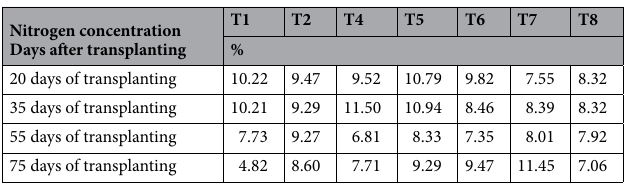
Table 3. Estimated nitrogen concentrations of the soil samples measured using dielectric conductivity at 1000 Hz.